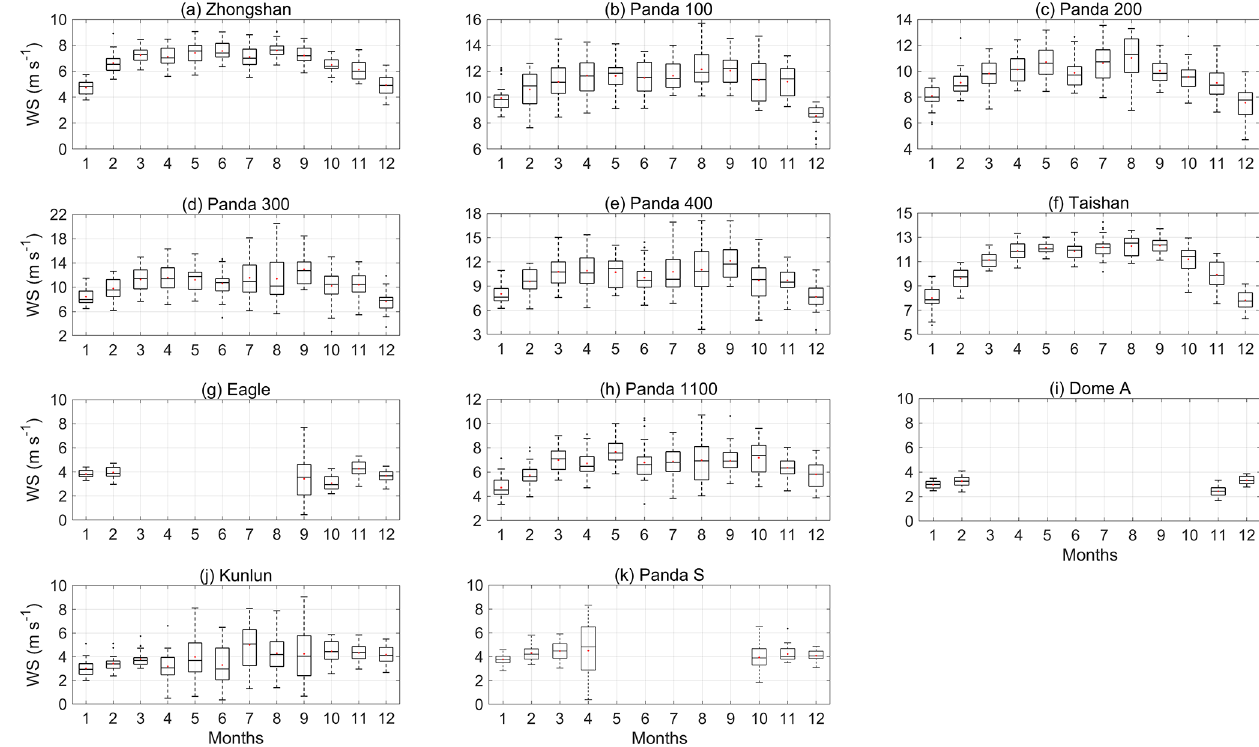
Figure 10. Monthly variation in wind speed of the PANDA AWS network. The calculation periods for these sites are the same as for Fig. 1.